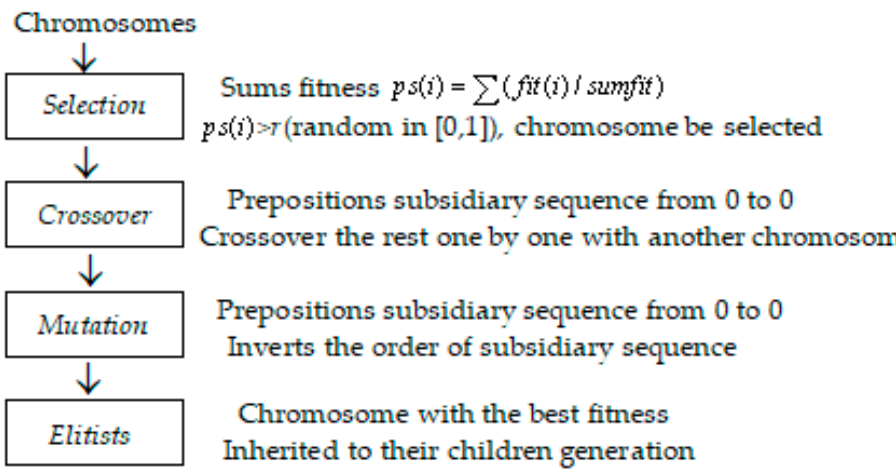
Figure 3. Optimization iteration of the NR-EGA.